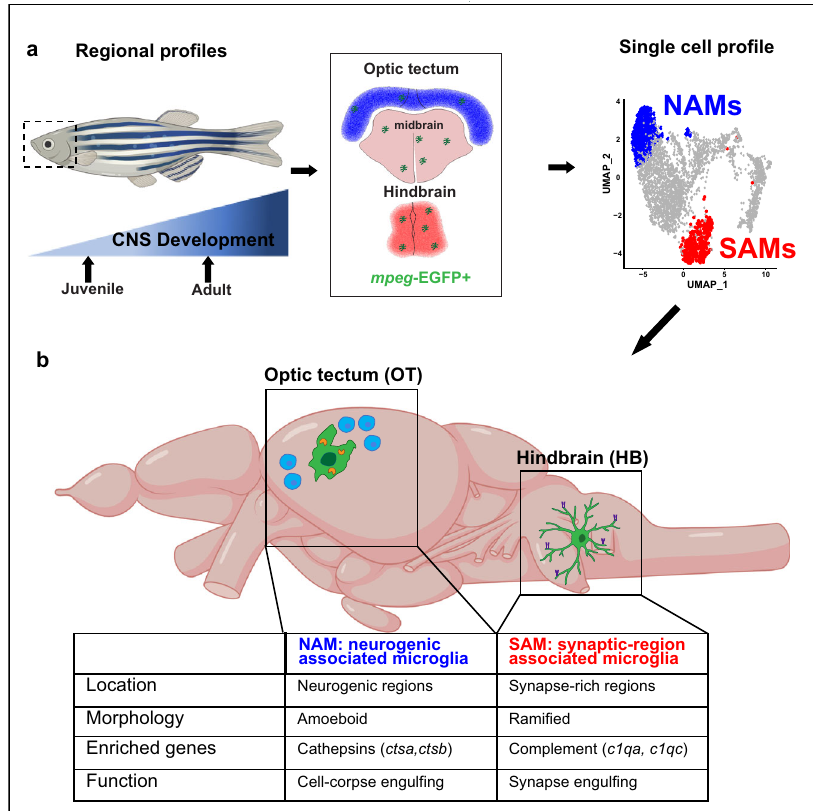
Fig. 5 Summary diagram of the identi fi ed neurogenic-associated microglia (NAMs) and synaptic-region associated microglia (SAMs) in the developing zebra fi sh brain. a Schematic of analysis pipeline overlaying brain-region-de fi ning genes identi fi ed with bulk-sequencing onto mpeg1.1 + scRNA seq clusters identify NAMs and SAMs. b Unique features of NAMs and SAMs in the developing juvenile brain. Adapted from BioRender.com (2020). Retrieved from